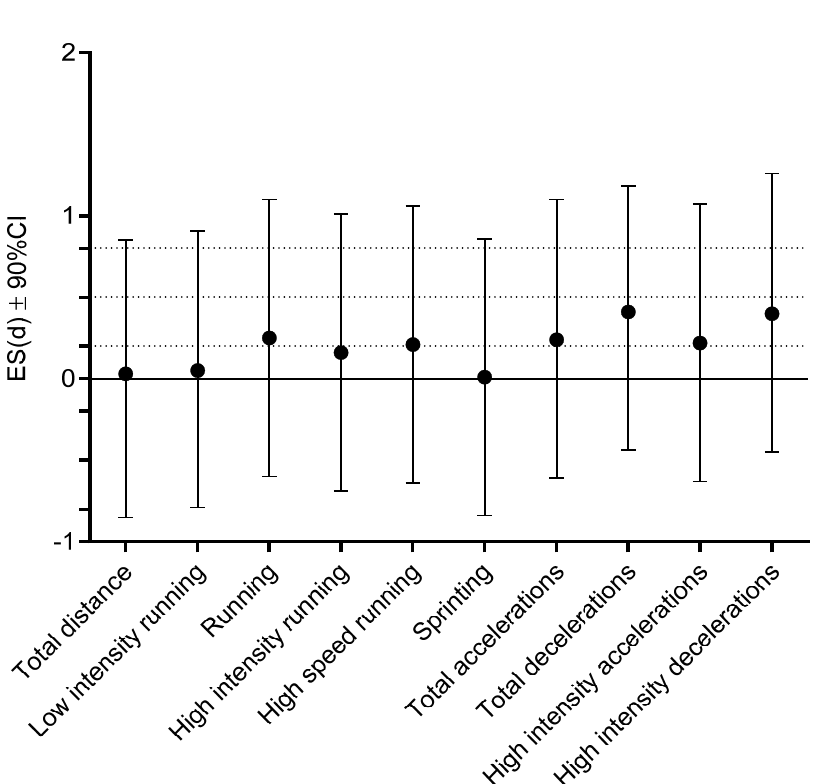
Figure 4. Effect size (ES) differences for match running performances between non-infected players and infected players after return to play (dashed lines present ES ranges: <0.02 = trivial; 0.2–0.6 = small; >0.6–1.2 = moderate; >1.2–2.0 = large; and >2.0 very large differences).